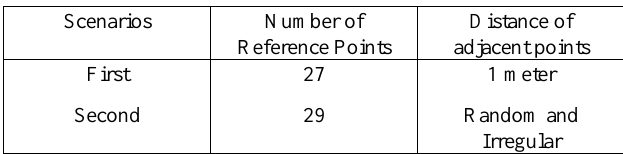
Table 1. Specifications of each scenario